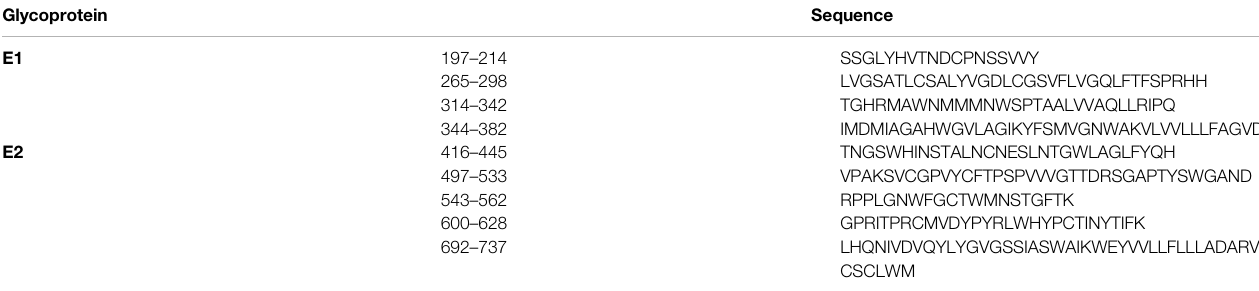
TABLE 3 | Sequences within the E1 and E2 fusion proteins examined as part as possible membranotropic peptides in the current discussion. Glycoprotein